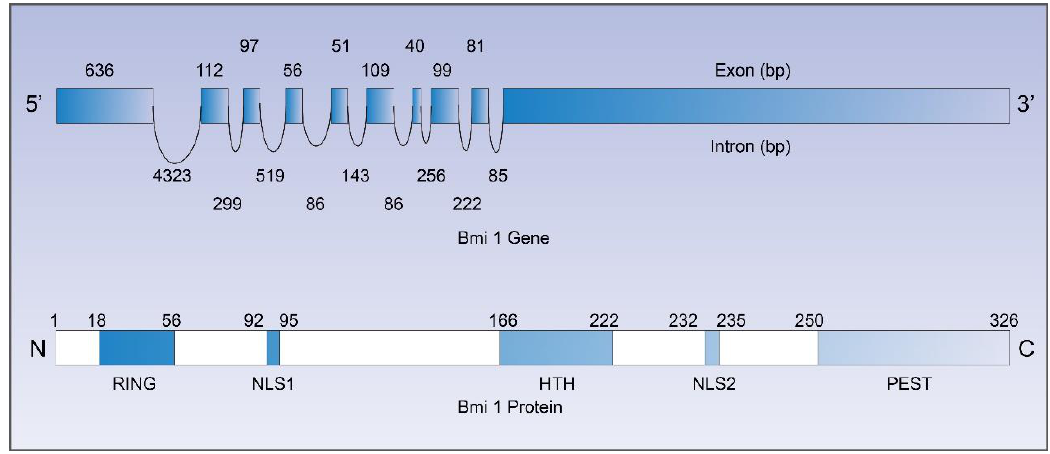
Figure 1. The structure of gene and protein of Bmi-1. The Bmi-1 gene contains 10 exons and 9 introns. The amino acid sequence of Bmi-1 protein contains a RING finger domain, a helix–turn–helix, two nuclear localization signals (NLS), and a PEST region.